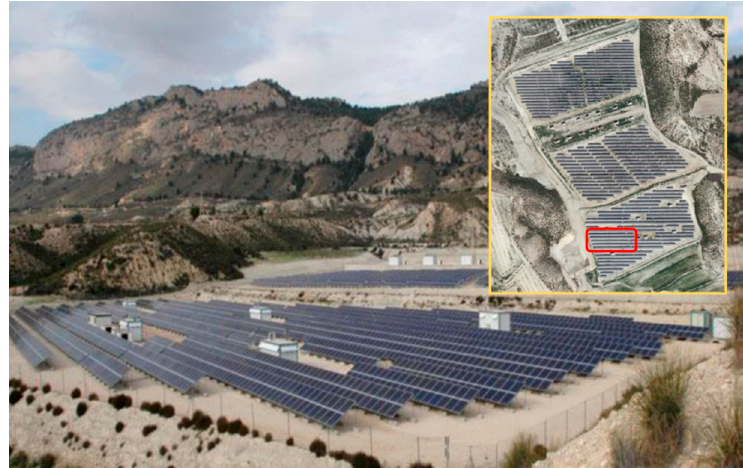
Figure 3. The 2.12 MW p Yéchar photovoltaic plant (Murcia), in the inset the sector of modules which have been monitored using thermographic camera is